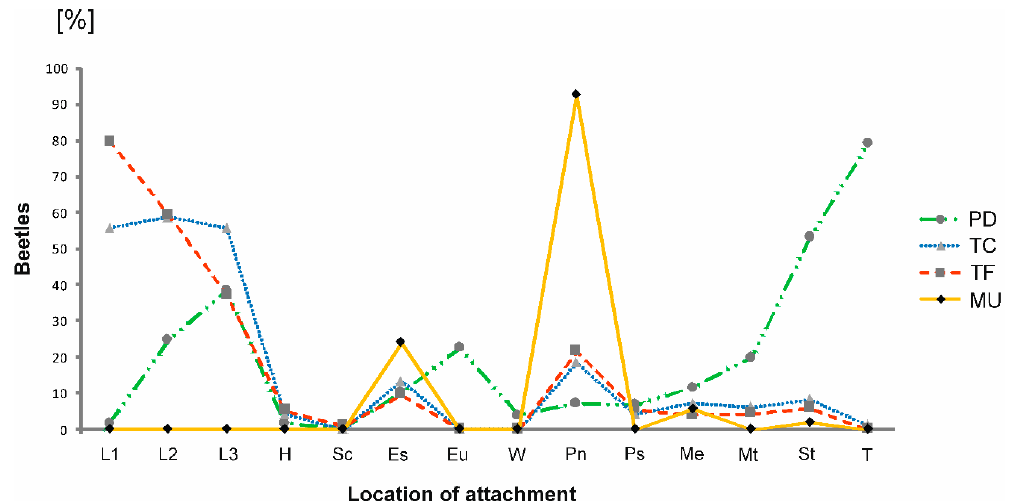
Figure 4. Frequency of individuals of beetles carrying the phoretic deutonymphs on various parts of their bodies: ( PD ) Plagionotus detritus ; ( TC ) Tetropium castaneum ; ( TF ) Tetropium fuscum ; ( MU ) Monochamus sartor urussovii ; ( L1 ) forelegs; ( L2 ) midlegs; ( L3 ) hindlegs; ( H ) head; ( Sc ) scutellum; ( Es ) surface of the elytra; ( Eu ) subelytra; ( W ) membranous wings; ( Pn ) pronotum; ( Ps ) prosternum; ( Me ) mesoventrite; ( Mt ) metaventrite; ( St ) abdominal ventrites; ( T ) abdominal tergites. The colored lines serve as a guide to the eye.